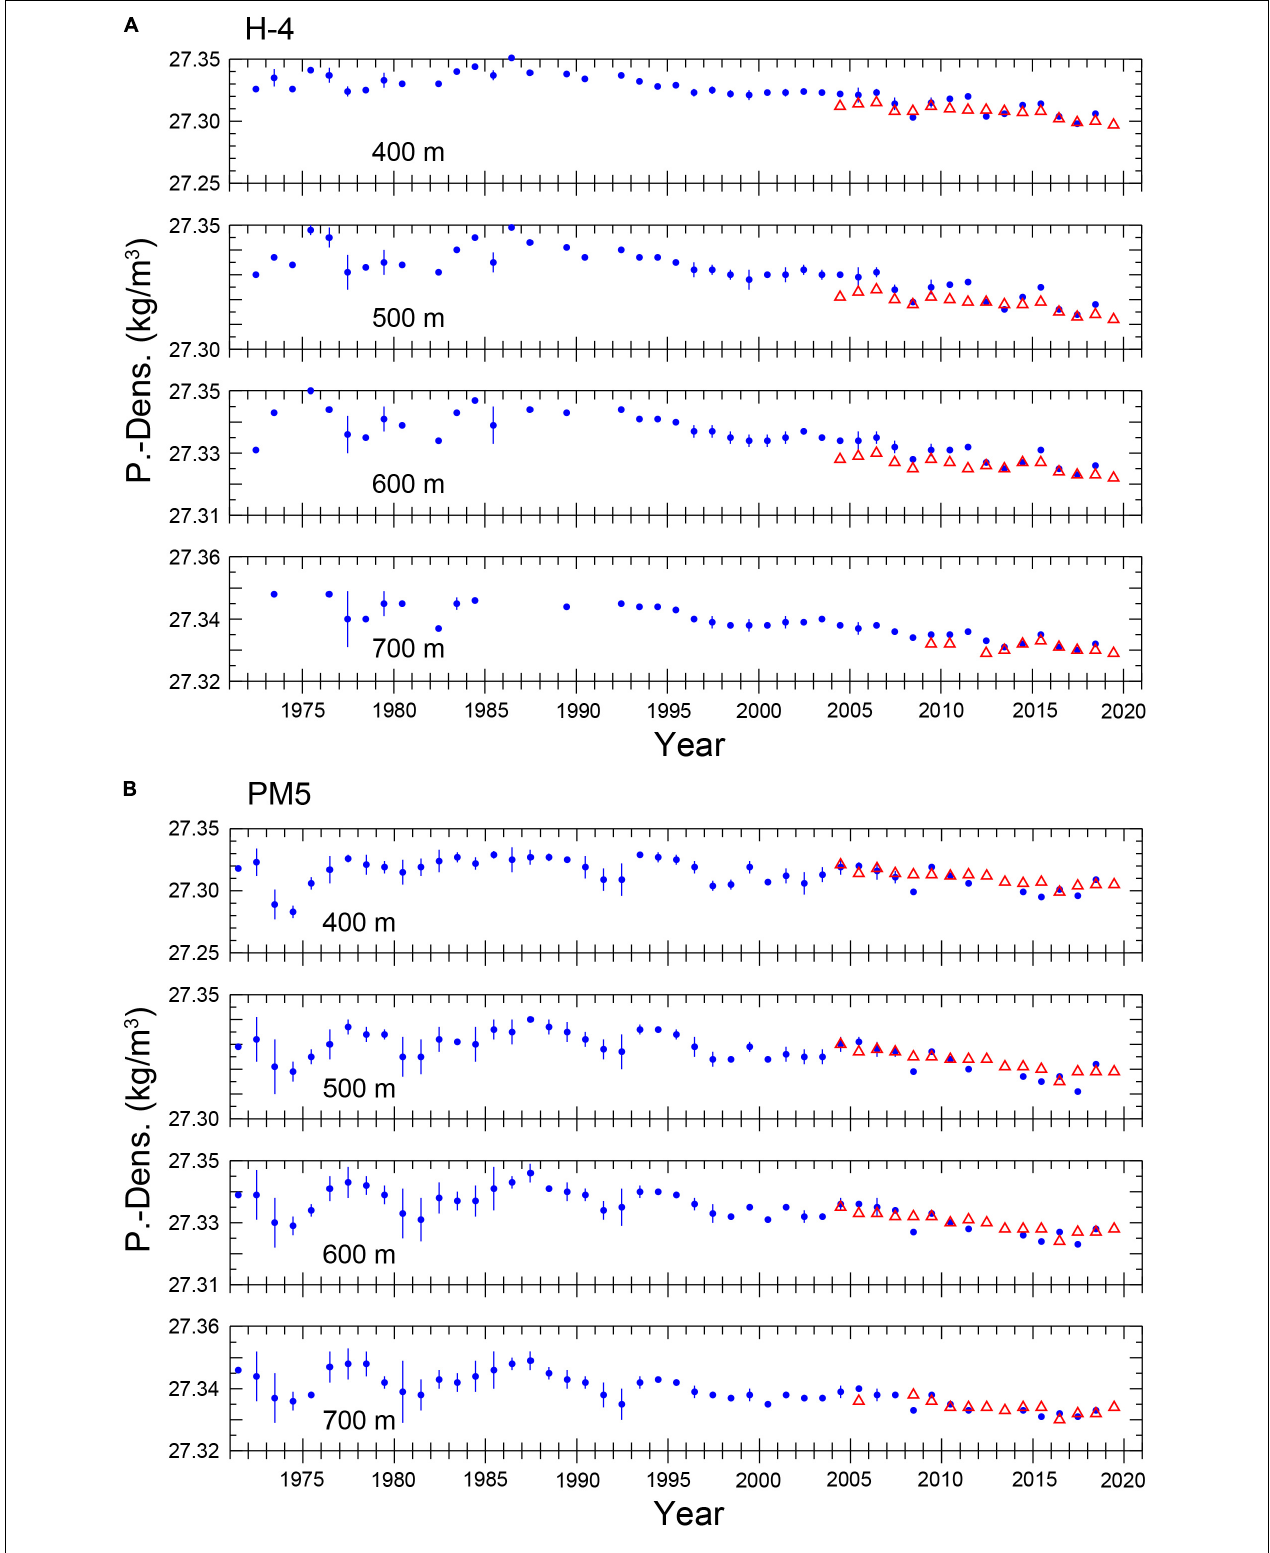
FIGURE 7 | Time series of the ship-based yearly mean PD at 400, 500, 600, and 700 m at (A) Stas. H-4 and (B) PM5. Vertical bars at each data point indicate one standard deviation. Red triangles in (A,B) indicate the Argo-based yearly mean PD in JE and YB, respectively.